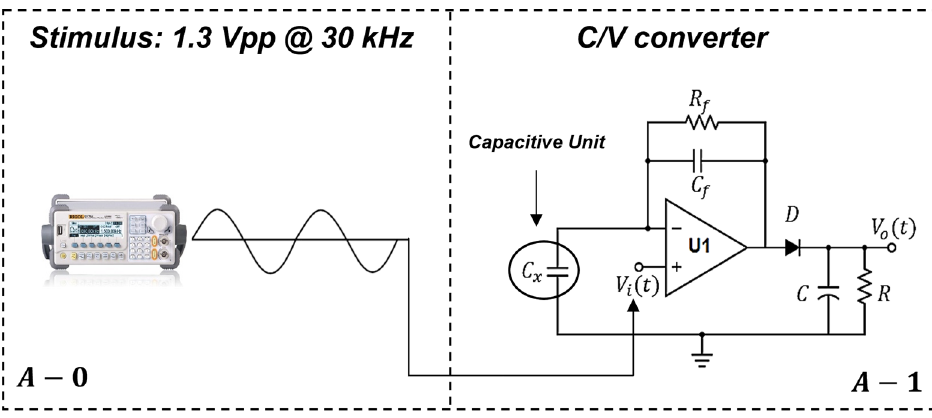
Figure 4. Electronic characterization circuit for the single capacitive sensor unit ( C x ).